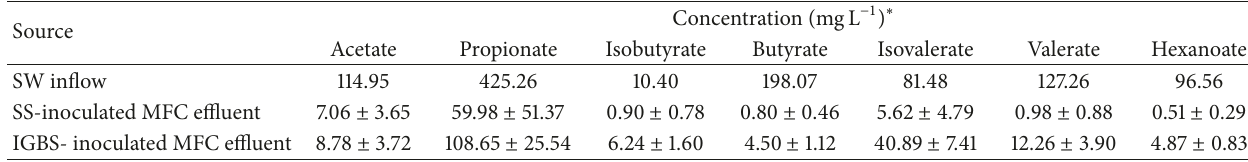
Table 2: Removal of selected volatile fatty acids by swine wastewater-fed microbial fuel cells.